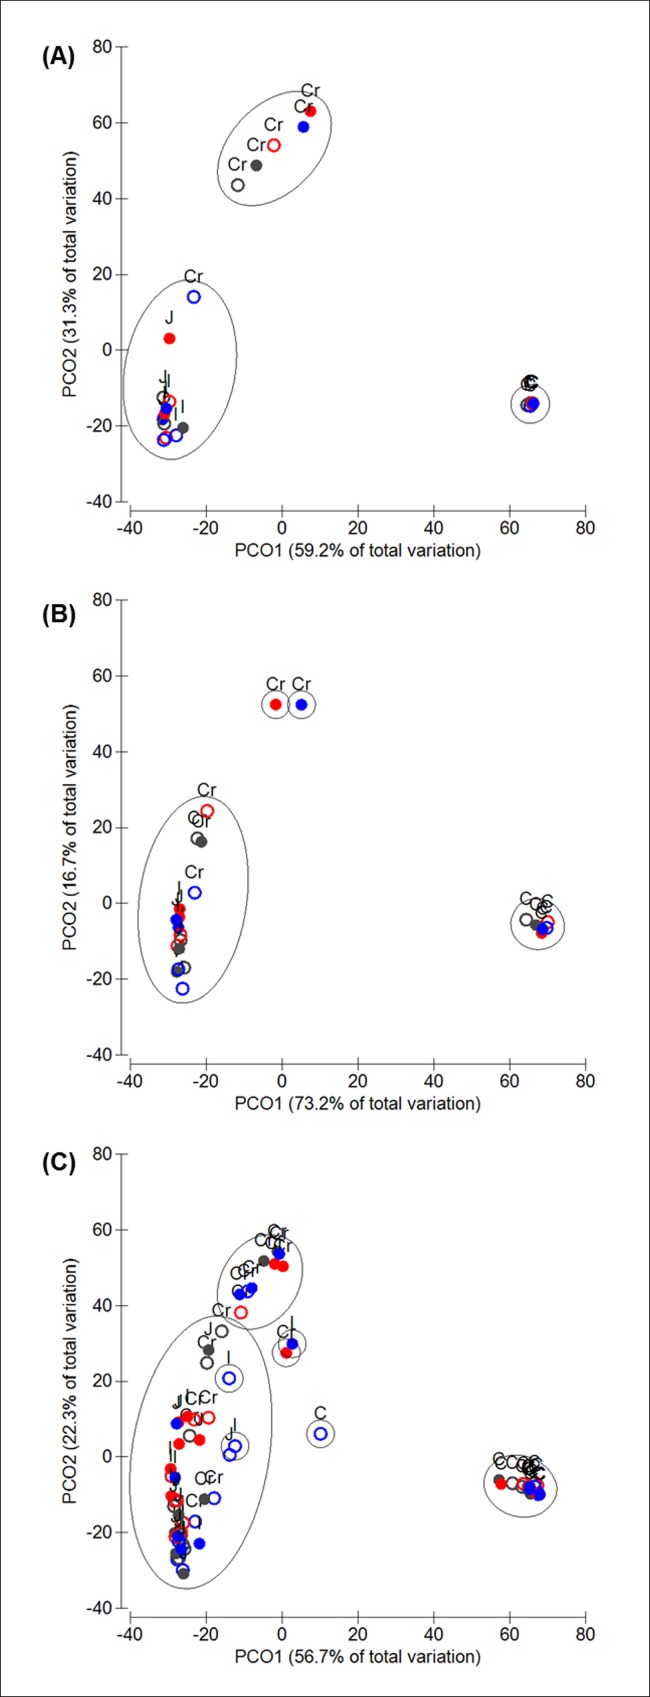
Principle coordinate analysis (PCoA) depicting the shifts in bacterial communities among the gastrointestinal tract of broilers fed with different diets varying in supplementation of monocalcium phosphate: BD- (open circles) and BD+ (close circles) and different levels of phytase: 0 (black), 500 (red), 12,500 (blue) FTU/kg feed, as detected by 454-pyrosequencing (A) and T-RFLP of pooled samples (B) and single replicates (C).Clusters represent samples sharing more than 50% similarity of their bacterial communities.